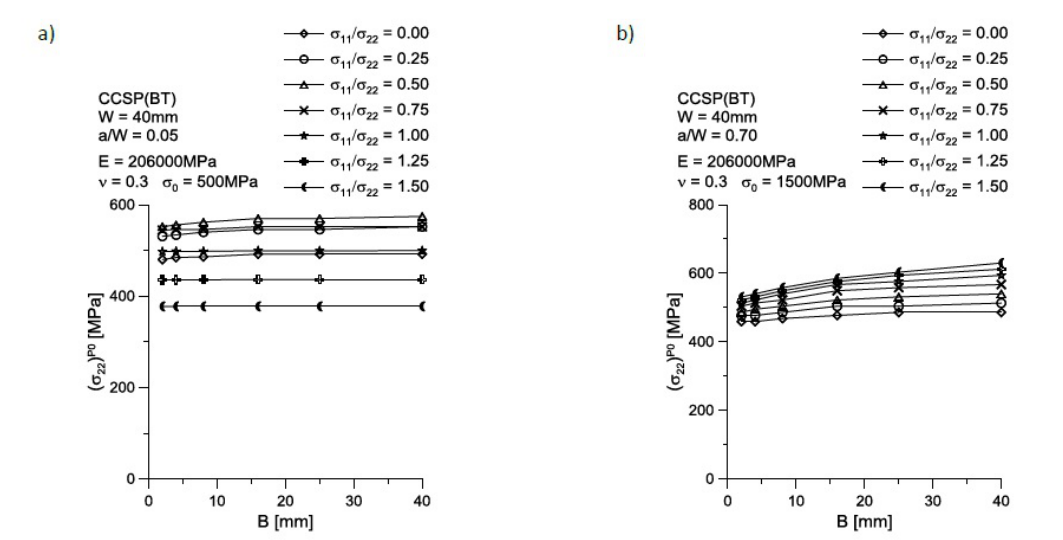
Figure 15: Limit load ( σ 22 ) P 0 vs. thickness for 3D cases at fixed values of the yield strength and the relative crack